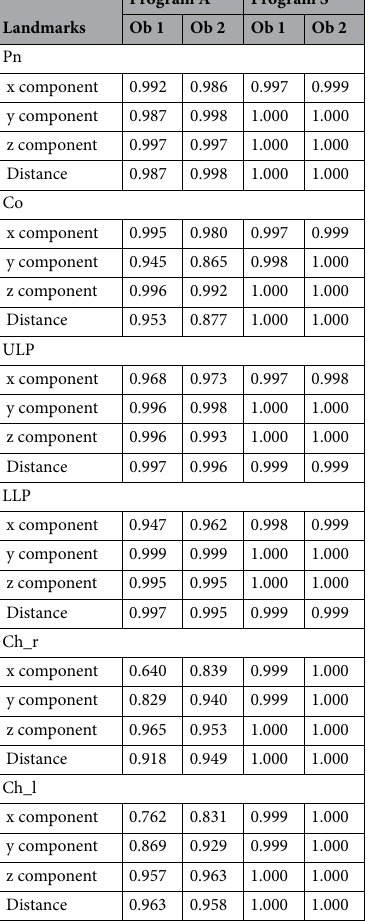
Table 2. The difference in intra-examiner reliability between Program A and Program S. Cronbach’s alpha coefficient was obtained to assess the intraclass correlation coefficient. Pn, Pronasale; Co, Columella; ULP, Upper lip point; LLP, Lower lip point; Ch_r, Cheek right; Ch_l, Cheek left; Ob 1, examiner 1; Ob 2, examiner